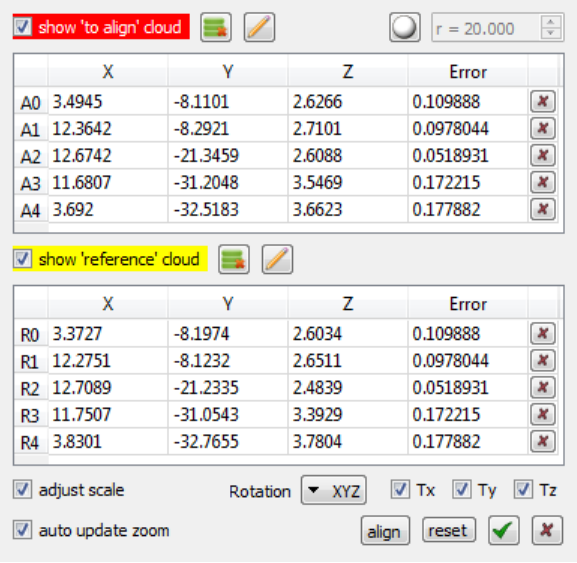
Figure 7: Residual errors of the Helmert transformation for the five panorama centres used as virtual control